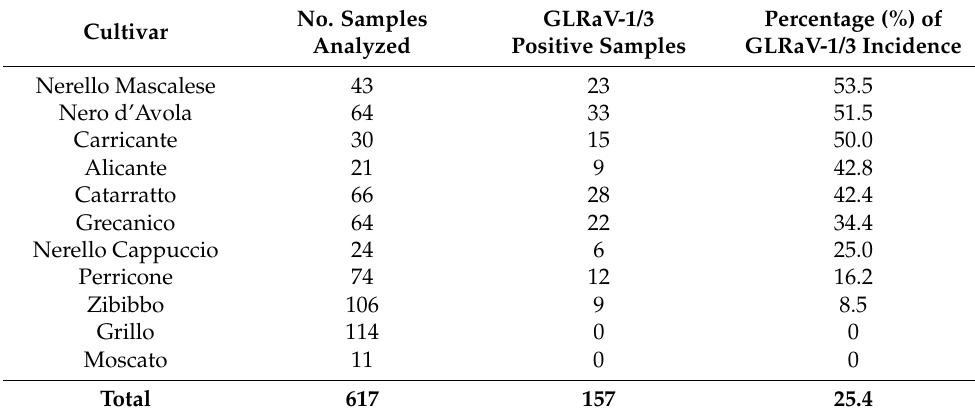
Table 3. Number of samples analyzed for GLRaV-1 and GLRaV-3 by DAS-ELISA. No. Cultivar